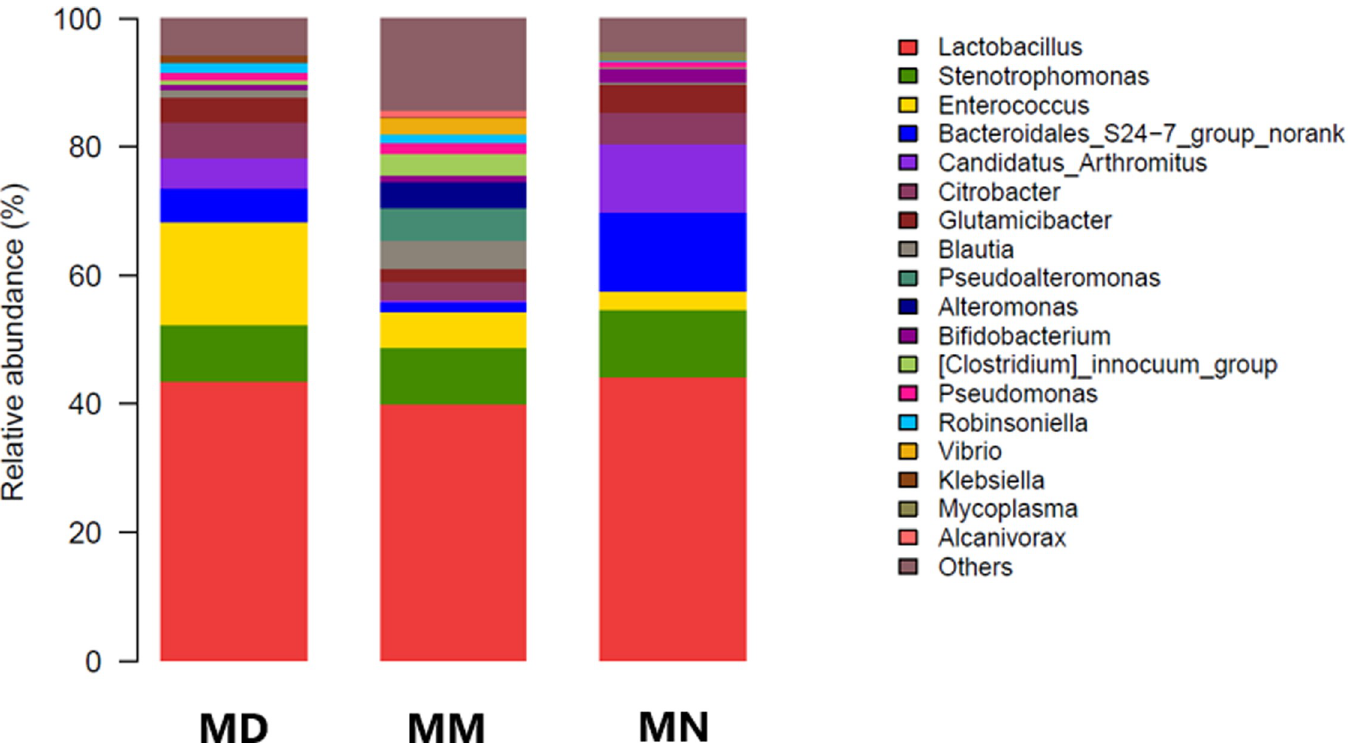
Fig 5. Bacterial distribution at the genus level. Bacterial distribution based on the genus taxonomical level in the normal group (MN), the model group (MM) and the treatment group (MD).